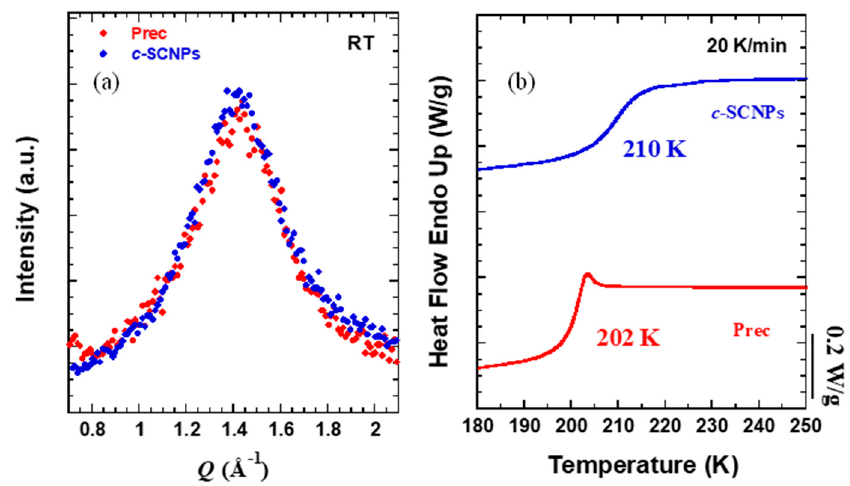
Figure 2. ( a ) WAXS diffraction patterns determined at room temperature (the intensity has been scaled to match at the maximum) and ( b ) heating DSC scans at 20 K/min.